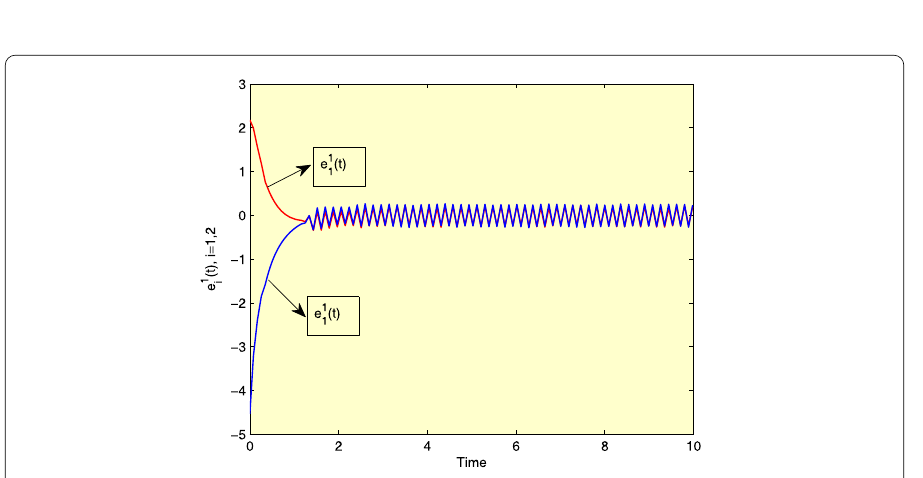
Figure 6 Synchronization curves of state variables e 1 1 ( t ), e 1 2 ( t ) of NN model (10) under controller